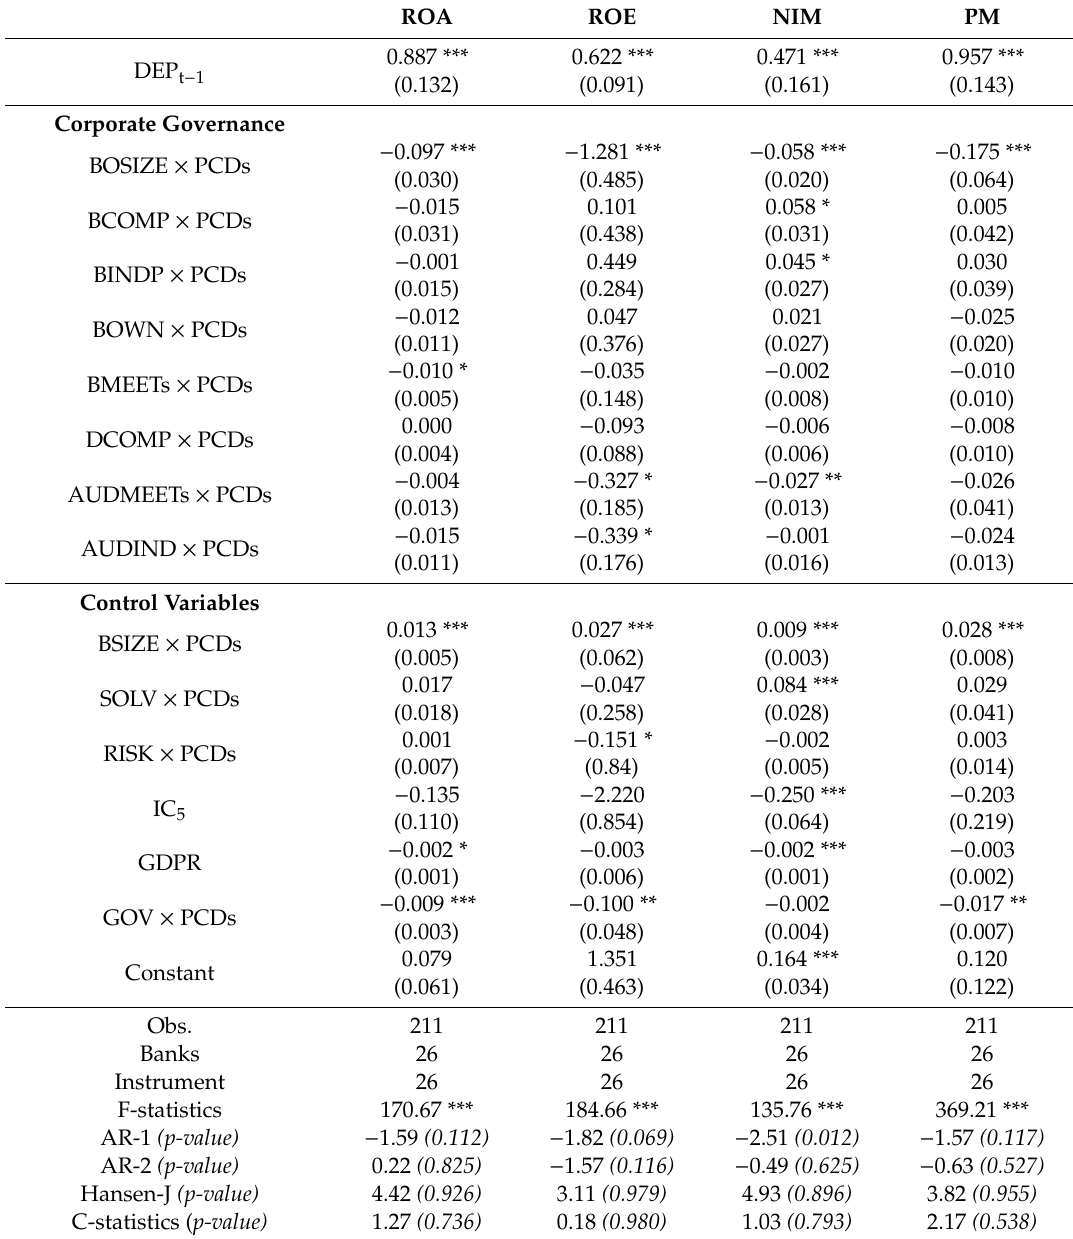
Table 6. Interaction e ff ect of politically connected directors